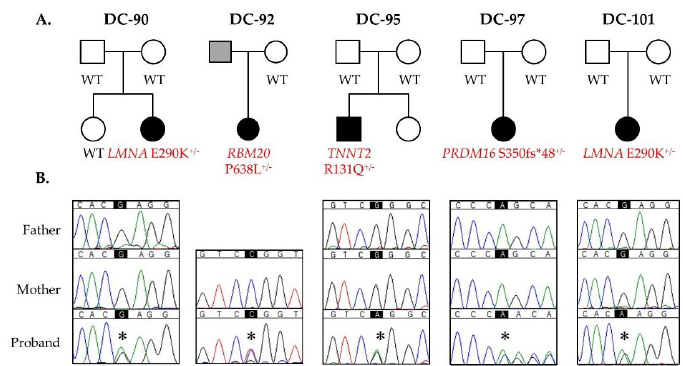
Figure 3. De novo mutations in LMNA , RBM20 , TNNT2 , and PRDM16 as a cause for sporadic pediatric DCM. ( A ) Pedigrees; ( B ) Sanger sequencing confirmed each de novo mutation. Asterisks indicate position of single nucleotide alterations.